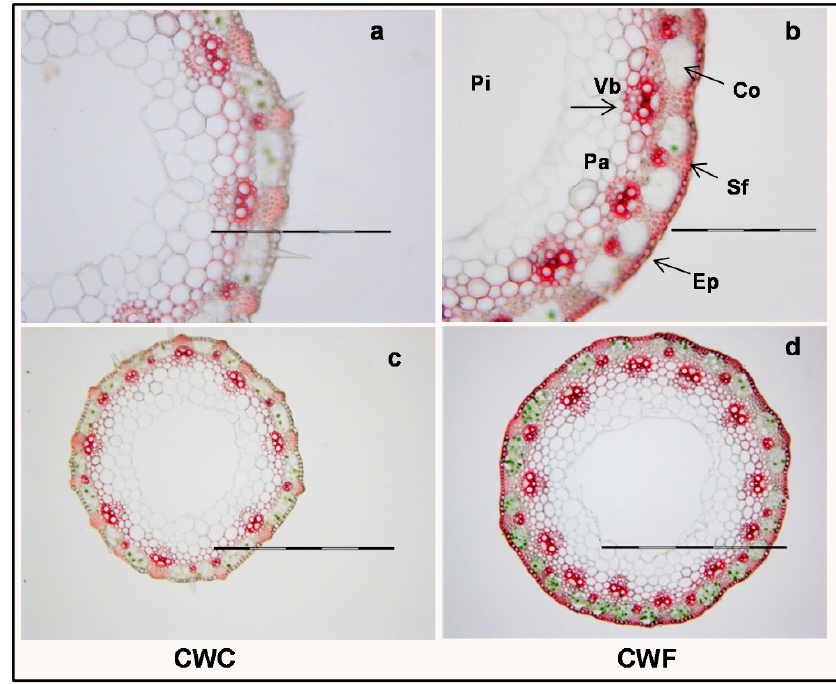
Figure 1. Brachypodium distachyon stem internode anatomy . Stem cross-sections 30 µm thick (between 3rd and 4th nodes, 7–10 days after the start of heading) from inbred accession lines 227011 (CWC) ( a , c ) and 255730 (CWF) ( b , d ), stained with phloroglucinol-HCl. The positions of the epidermis (Ep), sclerenchyma fiber (Sf), cortex (Co), vascular bundles (Vb), parenchyma (Pa) and pith (Pi) are indicated. Bar = 250 µm ( a ), 200 µm ( b ), 500 µm ( c , d ). Unpublished original data. Source M. Buanafina.